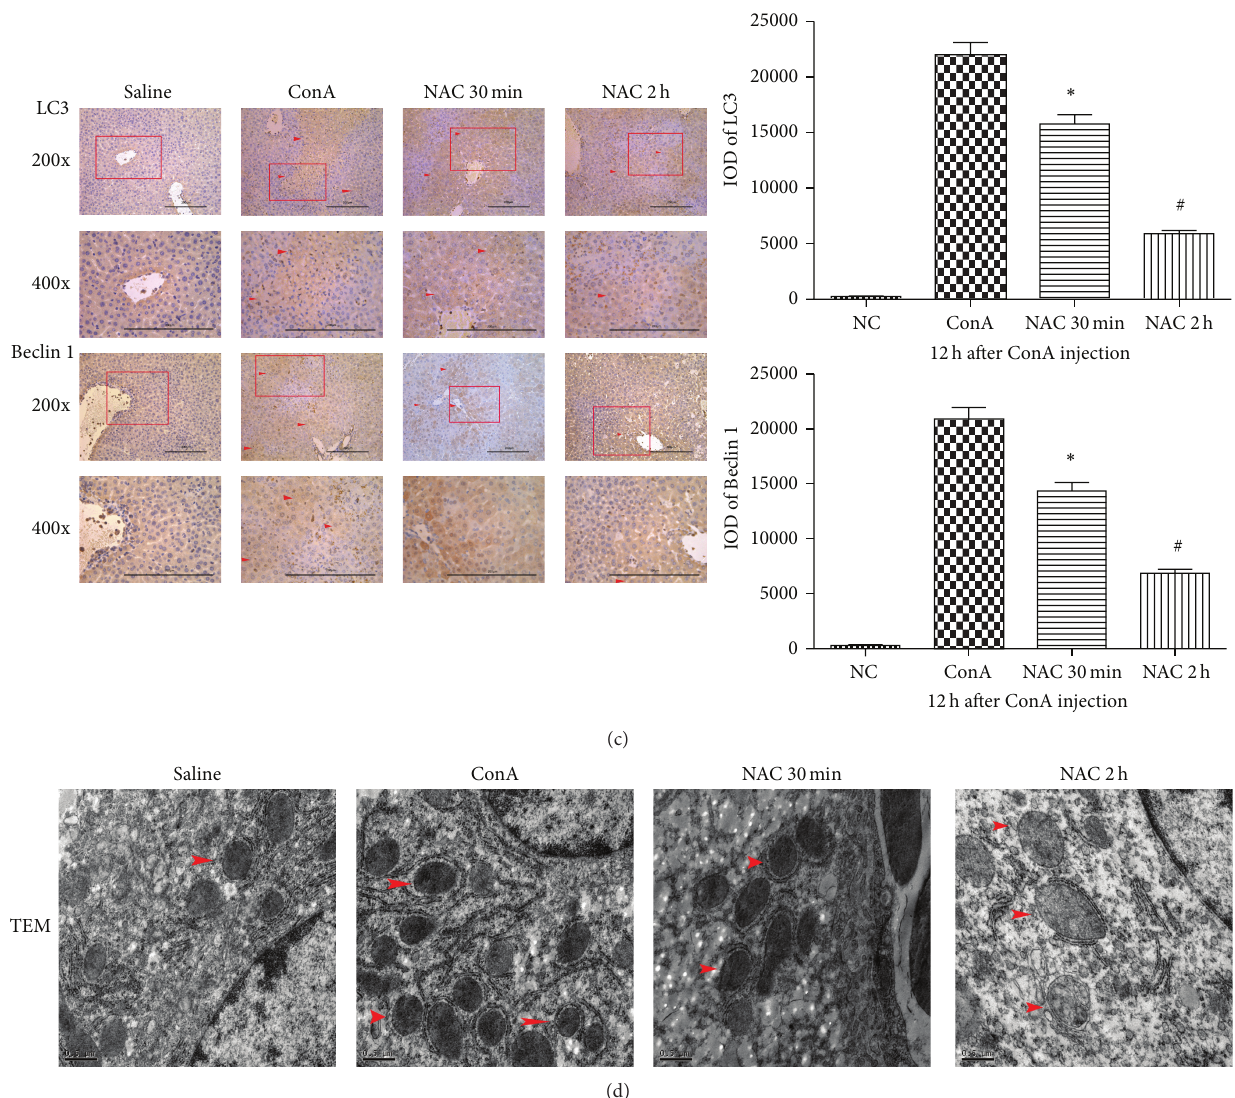
Figure 5: The effect of NAC on autophagy in ConA-induced hepatitis. (a) The expressions of LC3 and Beclin 1 on mRNA levels were detected by real-time PCR. Data are expressed as mean ± SD ( 𝑛 = 6 ; ∗ 𝑃 < 0.05 for ConA versus NAC 30 min; # 𝑃 < 0.05 for NAC 30 min versus NAC 2 h). (b) The expressions of LC3 and Beclin 1 on protein levels were detected with western blot. The expressions of LC3 and Beclin 1 on protein levels of macrophages and hepatocytes were detected by western blot at 12h time point. The results of western blot were analyzed with Quantity One. Data are expressed as mean ± SD ( 𝑛 = 6 ; ∗ 𝑃 < 0.05 for ConA versus NAC 30 min; # 𝑃 < 0.05 for NAC 30 min versus NAC 2h). (c) The expressions of LC3 and Beclin 1 on protein levels were detected by immunohistochemistry staining in hepatic tissues at 12h ( × 200 and × 400 magnification). The positive cells were indicated with red arrows. The result was analyzed using Image-Pro Plus 6.0. Date are showed as mean ± SD ( 𝑛 = 6 ; ∗ 𝑃 < 0.05 for ConA versus NAC 30min; # 𝑃 < 0.05 for NAC 30 min versus NAC 2h). (d) Morphology of autophagosomes in hepatocytes at 12 h detected by electron microscopy ( × 20000